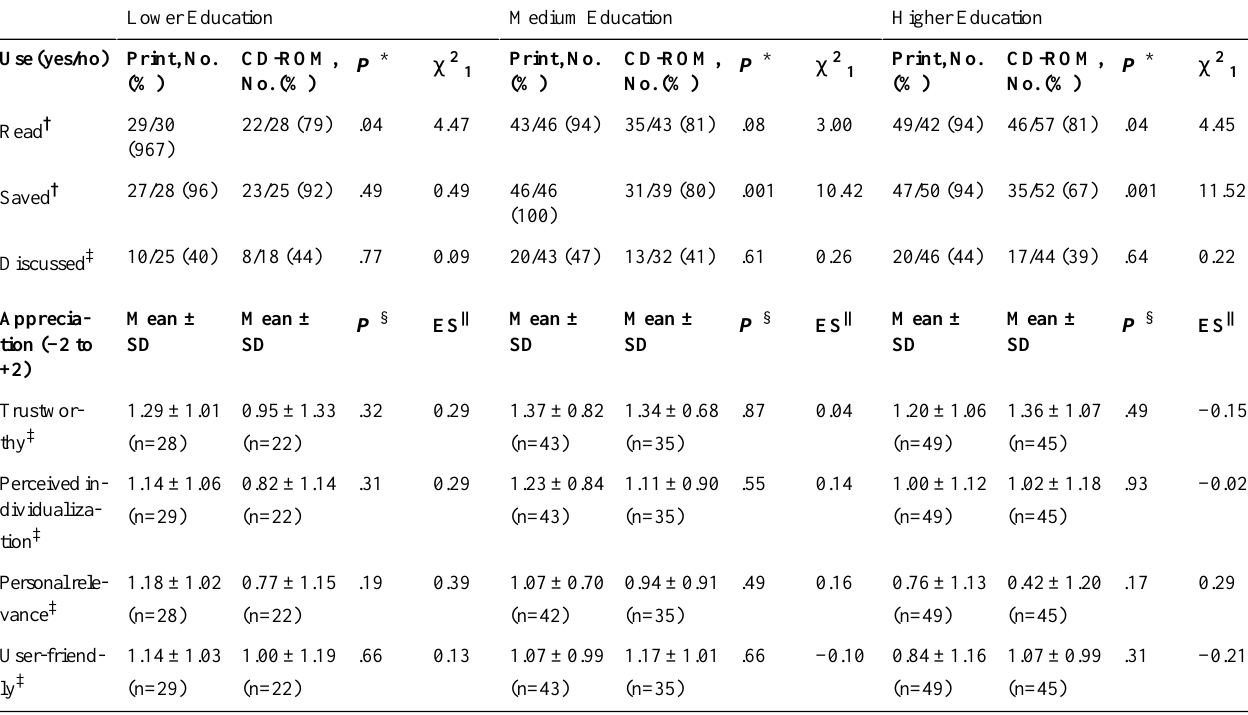
Table 3. Use and appreciation of the print- and CD-ROM-delivered, computer-tailored intervention, by education level